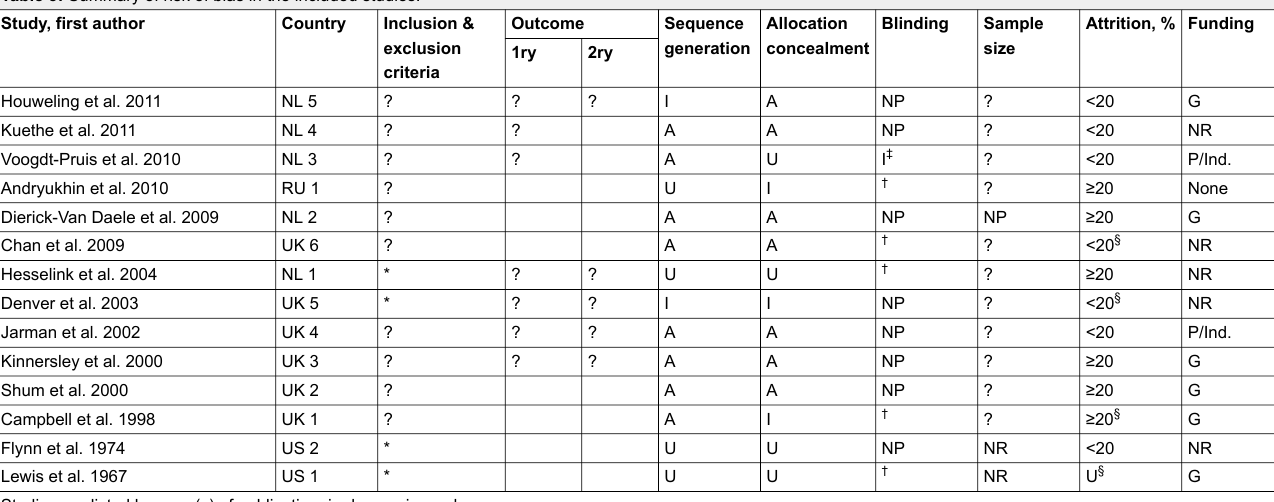
Table 3: Summary of risk of bias in the included